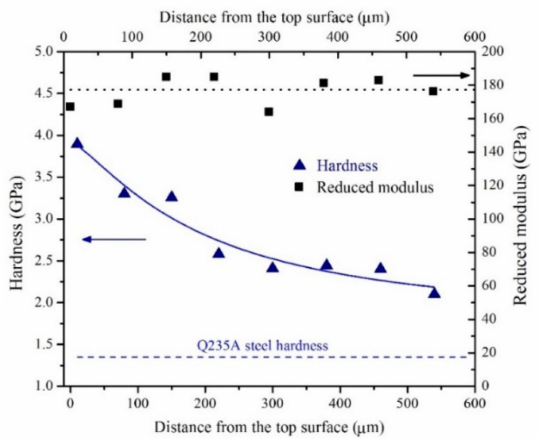
Figure 15. Variation of the nano-hardness and elastic moduli between the upper steel surface and steel base